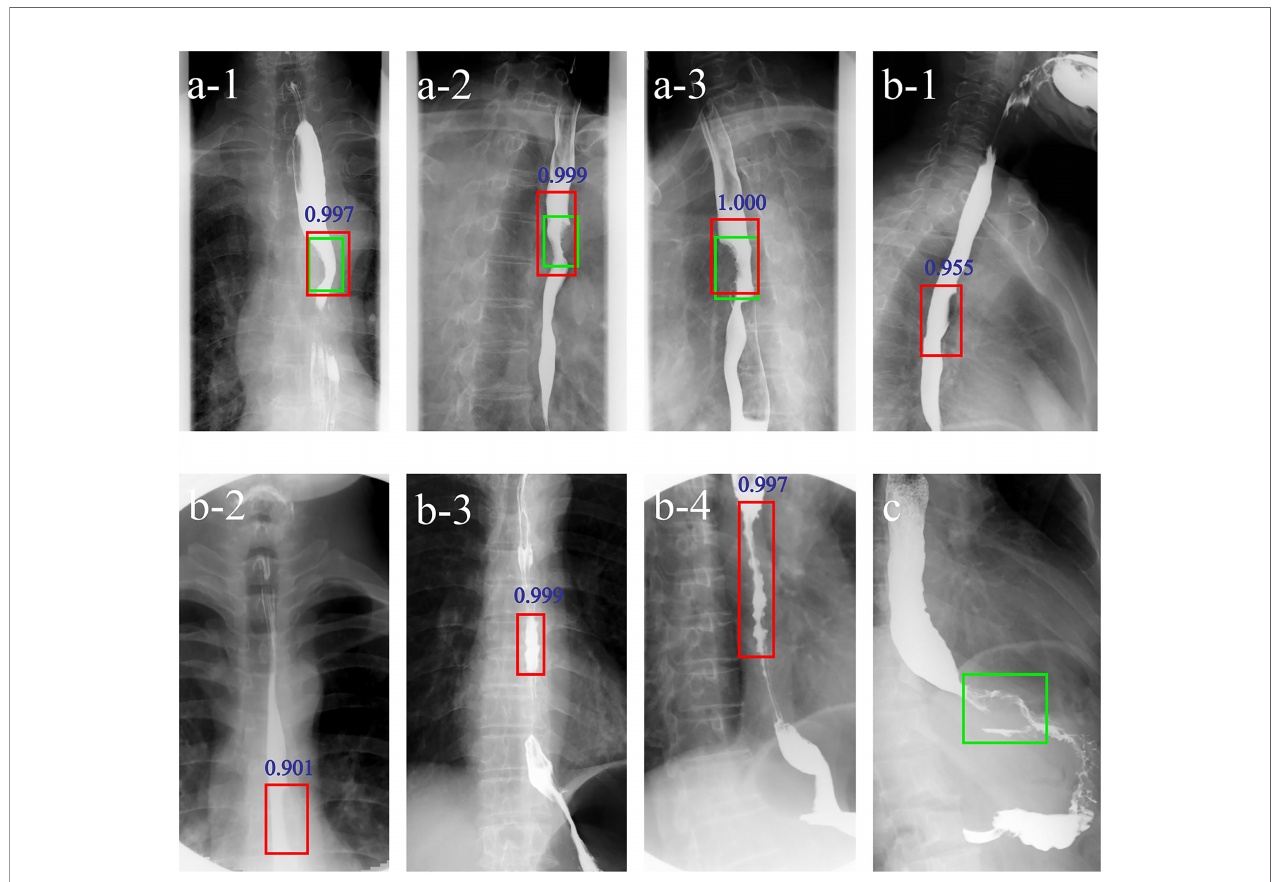
FIGURE 4 | Examples of DLS-diagnosed images. The green boxes indicate the ground truth annotated by radiologists. The red boxes and blue numbers indicate the positioning boxes and probability values outputted by the DLS. A - 1-A - 3 are true positive cases. B - 1-B - 4 are false positive cases. (C) is a false negative case. A-1 - 3 represent three positions (anteroposterior, right anterior oblique, and left anterior oblique view) of barium esophagrams from a 71-year-old male esophageal cancer patient. A fi lling defect and eccentric stenosis in the middle of the esophagus can be noticed. B-1 , B - 2 represent misdiagnosis of esophageal cancer based on the false fi lling defect caused by gas. B - 3 , B - 4 represent misdiagnosis of esophageal cancer based on tertiary waves (red boxes) in a 64- and a 78-year-old patient, respectively. (C) represents missed diagnosis of esophagogastric junction cancer. DLS , deep learning system.